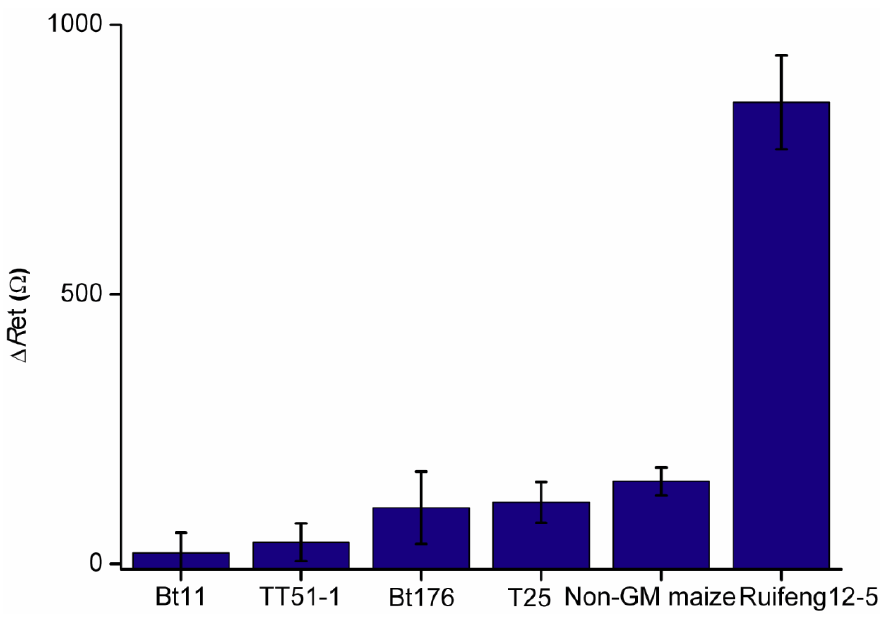
Figure 3. Specificity of the proposed RPA-based EI genosenor.